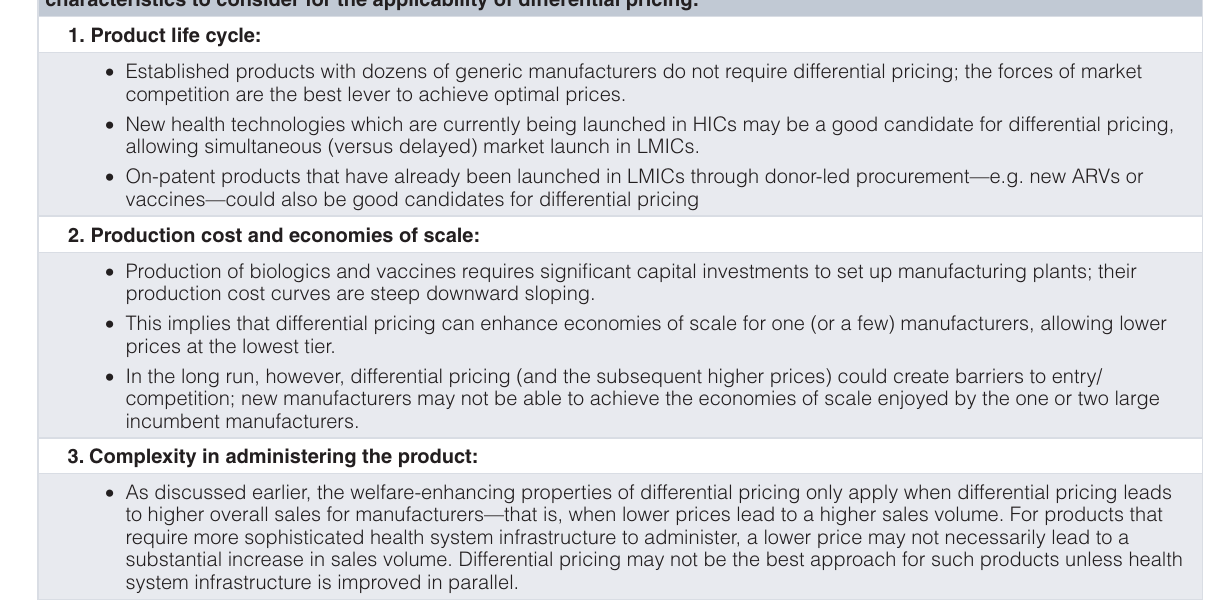
Table 1. Product and market characteristics for applicability of differential pricing. Differential pricing can only create welfare gains for certain product and market types. There are three main product characteristics to consider for the applicability of differential